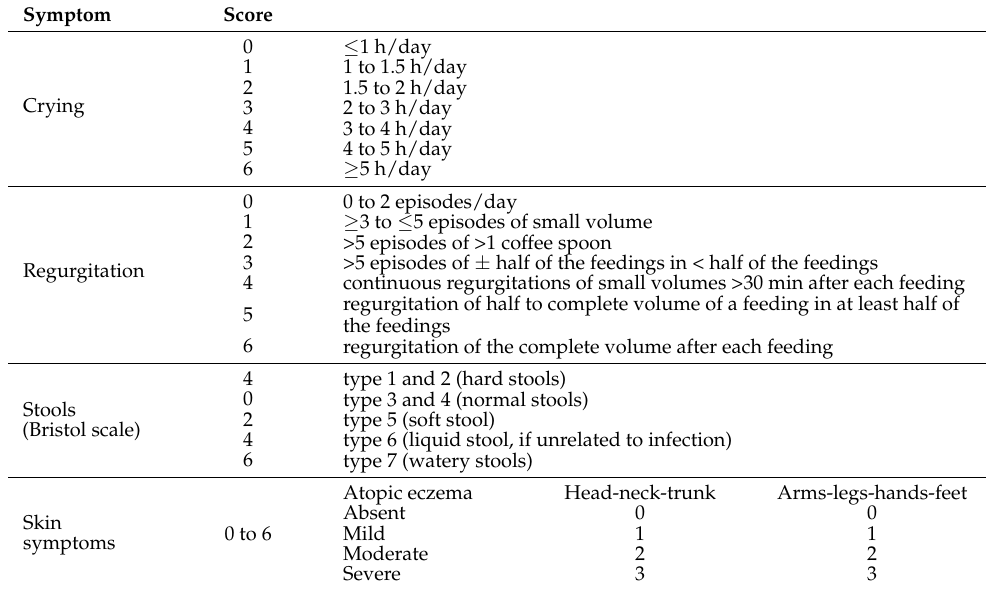
Table 2. The Cow’s Milk-associated Symptom Score (CoMiSS ® ) value